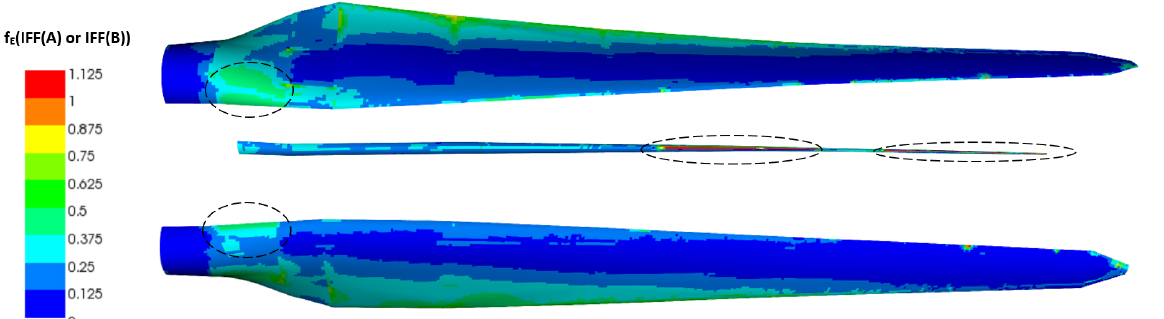
Figure 23. Damage evolution – IFF (A) or IFF (B) – in the pressure side, internal flange and suction side of the blade (from top to bottom) at 140% of extreme edgewise loading.